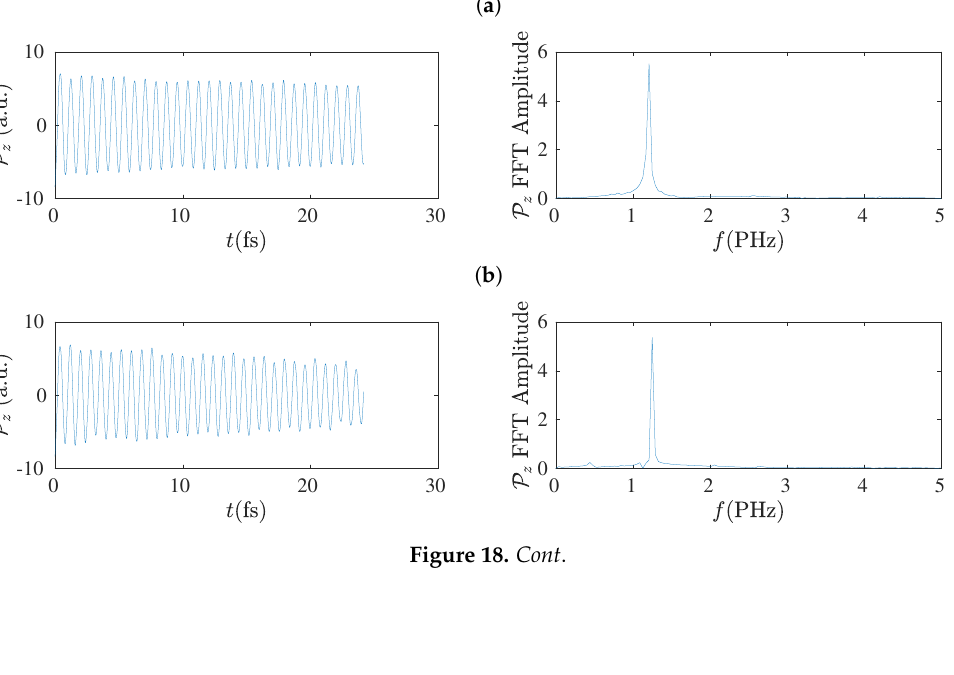
Figure 17. Left column: Dipole moment oscillations along the z -axis, P z , obtained by RT-TDDFT at the B3LYP/cc-pVTZ level of theory, for N = 7, for cumulenic ( cu ) molecules with coplanar ( co ) and perpendicular ( pe ) methylene groups as well as for polyynic ( po ) molecules starting with short ( sl ) or long ( ls ) bonds. Right column: The corresponding Fast Fourier Transform (FFT) amplitudes obtained by MATLAB. ( a ) cu co , ( b ) cu pe , ( c ) po sl , ( d ) po ls . ( a )